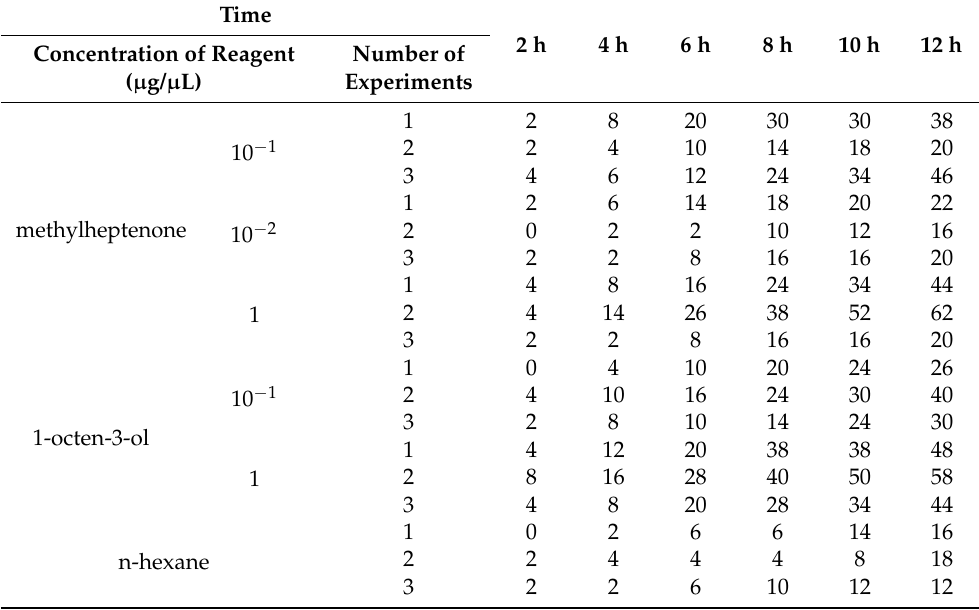
Table 6. Statistical table of the trapping experiment for female W. magnifica with different concentra- tions of methylheptenone and 1-octen-3-ol.